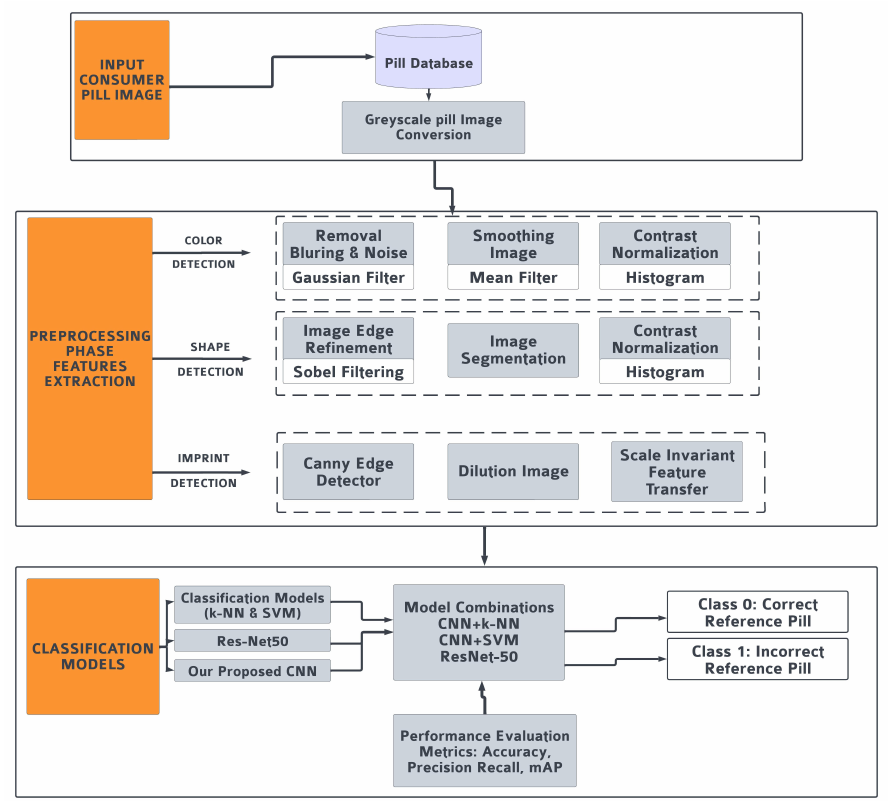
Figure 1. Proposed